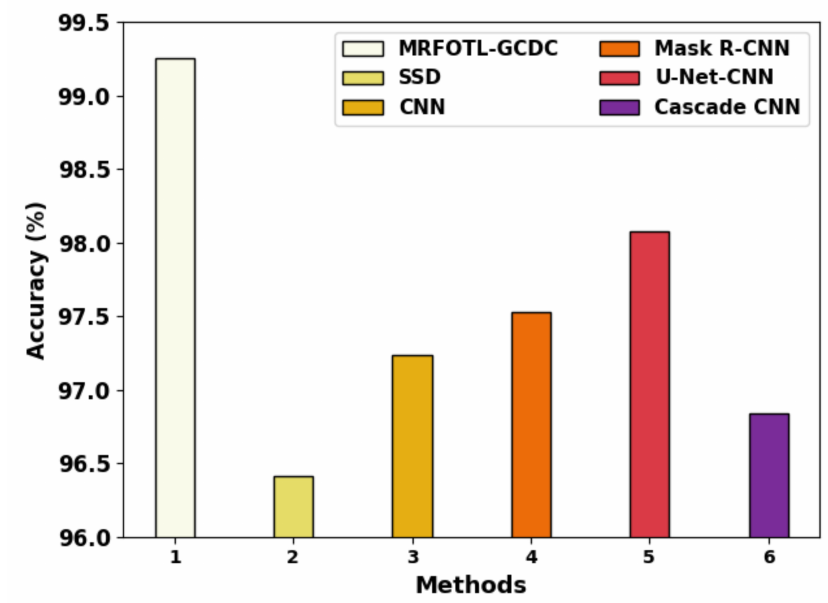
Figure 12. Accu y analysis of MRFOTL-GCDC system with other existing approaches. Finally, based on the F score , the MRFOTL-GCDC approach has shown an increased F score of 98.60%, whereas the SSD, CNN, Mask R-CNN, U-Net-CNN, and cascade CNN models have reported reduced F score values of 96.26%, 97.91%, 97.67%, 95%, and 97.58% correspondingly. These results reported the improvement of the MRFOTL-GCDC